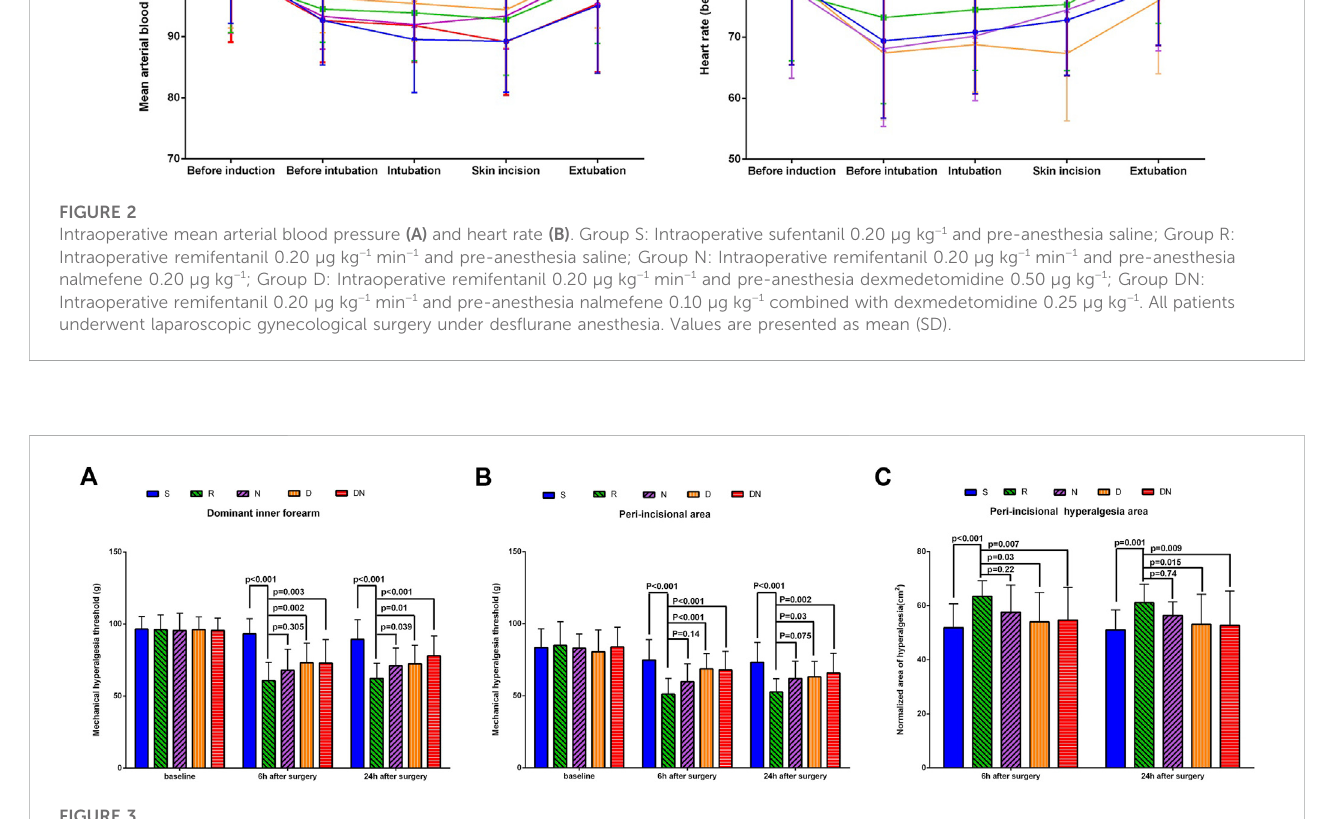
Table 1). When compared with Group R, Group S exhibited delayed